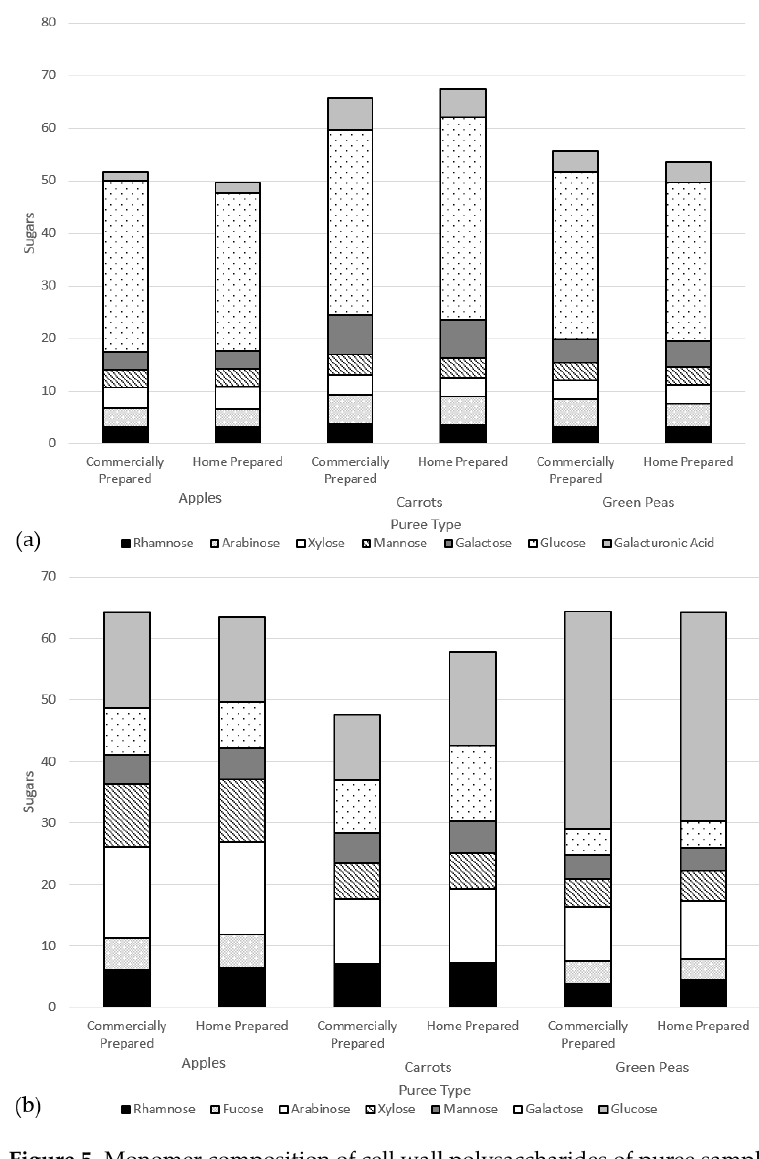
Figure 5. Monomer composition of cell wall polysaccharides of puree samples (dry weight basis) of the ( a ) soluble fractions and ( b ) insoluble fractions.